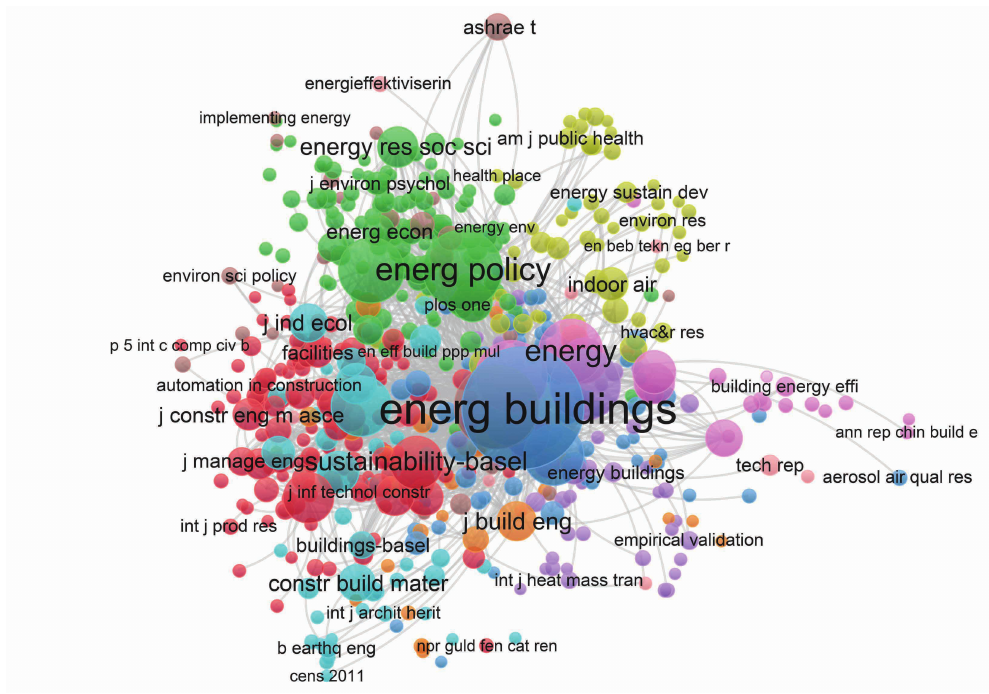
Figure 3. Co-citation of